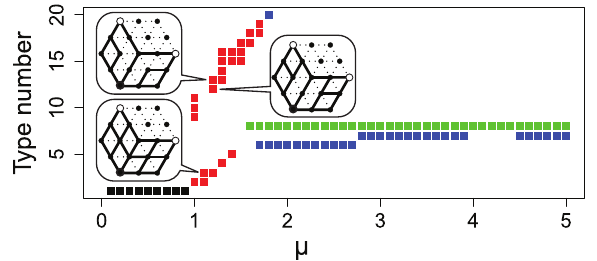
Figure 3. Network types calculated with oscillating inputs and outputs. A type number is assigned to each topology. The full list of network topologies is represented in Fig. S1. The data are those for the homogeneous initial conditions of D ij . The plots of mesh, partial mesh, V-shaped and Y-shaped networks, are colored in black, red, blue, and green, respectively. The dependence of type of partial mesh on is shown in Fig.